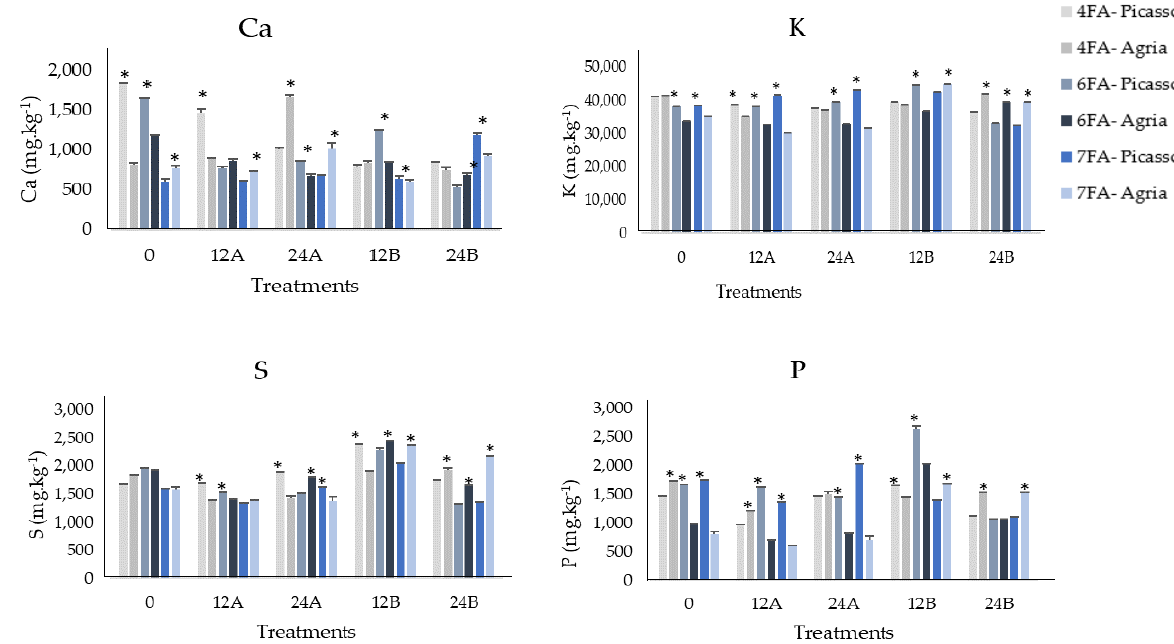
Figure 8. Chemical elements in tubers of S. tuberosum L. Agria and Picasso varieties, during the production cycle of plants, after the fourth, sixth, and seventh foliar application with CaCl 2 and Ca(EDTA). Foliar spray was carried out with two concentrations of CaCl 2 (12 (corresponding to 12A) and 24 (corresponding to 12B) kg · ha − 1 ) and two concentrations of Ca-EDTA (12 (corresponding to 12B) and 24 (corresponding to 24B) kg · ha − 1 ). The control was not sprayed at any time and corresponds to “0”. Chemical quantification was carried out after the fourth (corresponding to 4FA), sixth (corresponding to 6FA), and seventh (corresponding to 7FA) foliar applications. Mean values ± S.E. ( n = 4) and significantly higher content between varieties within each treatment after the 4FA, 6FA, and 7FA are identified (*).